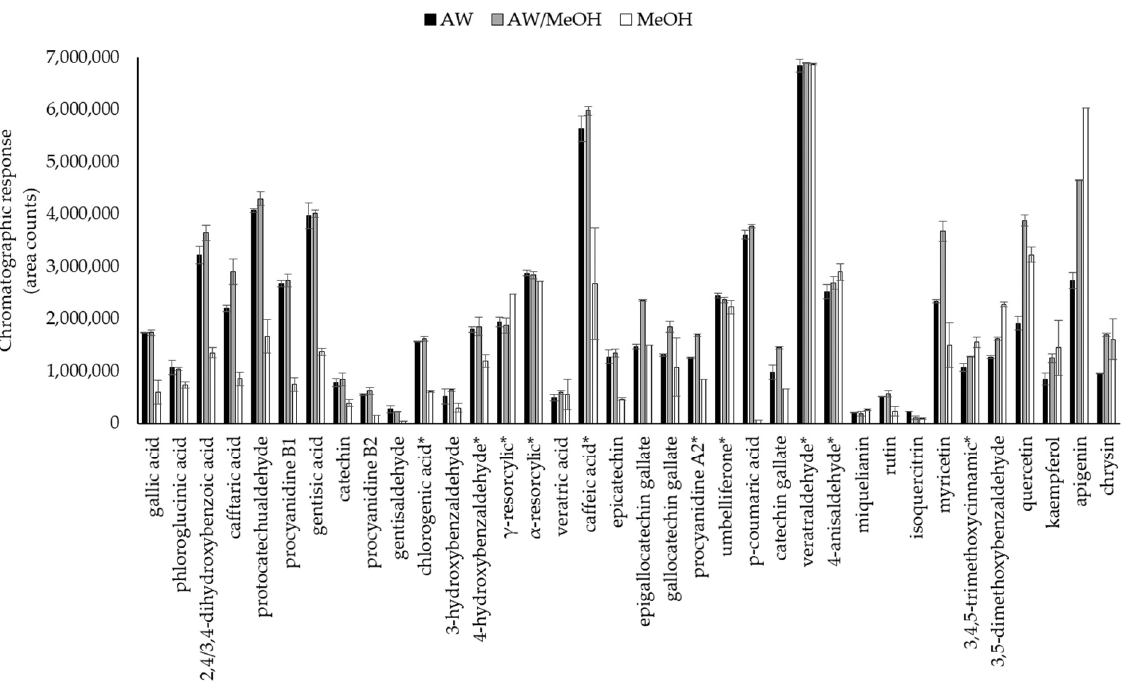
Figure 2. Chromatographic response for some phenols standard solutions (200 µg L − 1 ) prepared in AW: acidified water (0.1% formic acid); AW/MeOH: acidified water (0.1% formic)/methanol (80:20, v / v ); MeOH: methanol. * Divided/10.